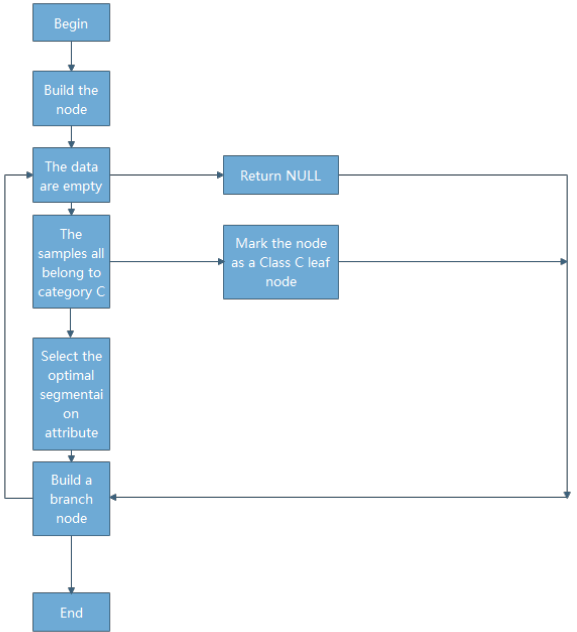
Figure 1. The basic flow chart of the decision tree.